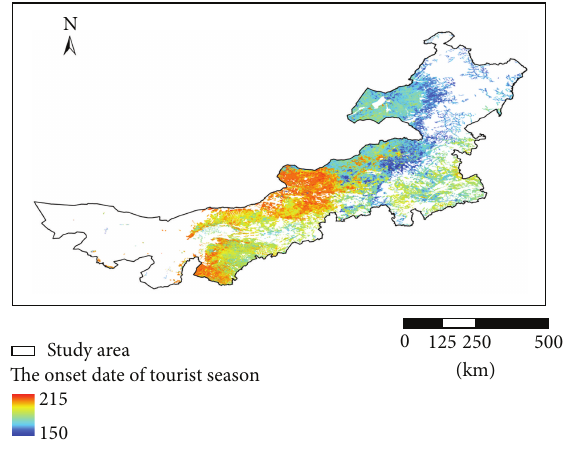
Figure 4: The onset of grassland tourist season.